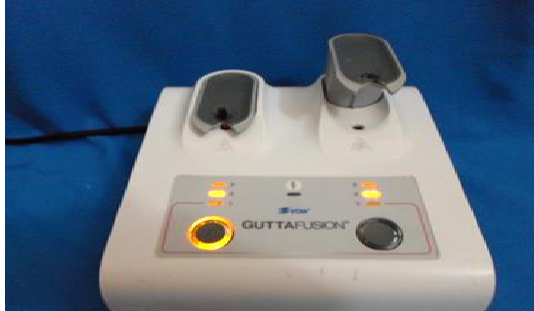
Figure 3: GuttaFusion® oven with